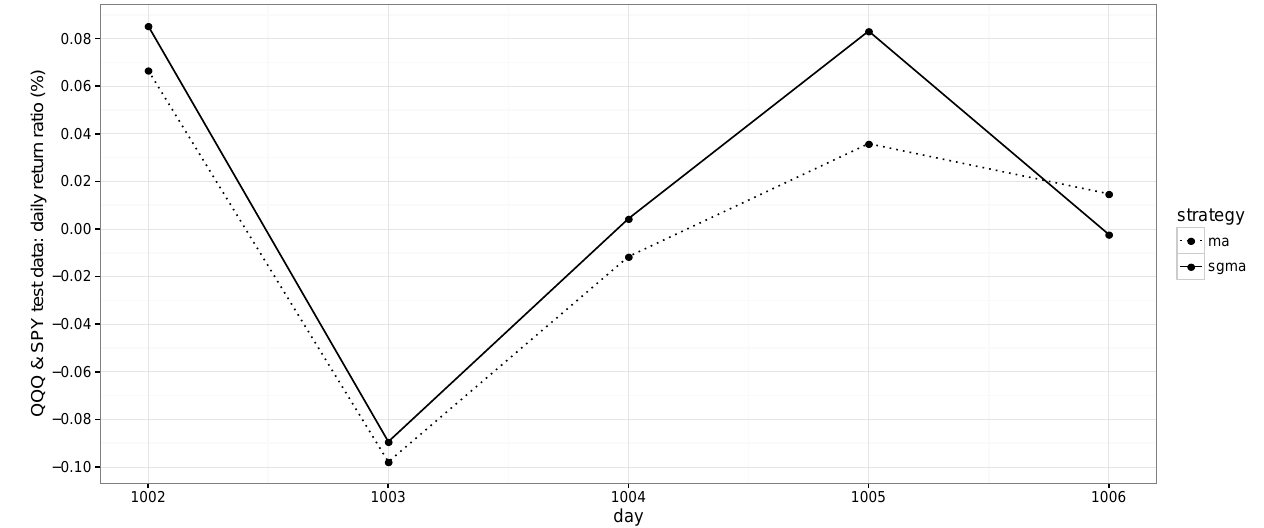
Figure 3. Case 1—MGMA strategy evaluation summary plot for QQQ ETF and SPY ETF on day